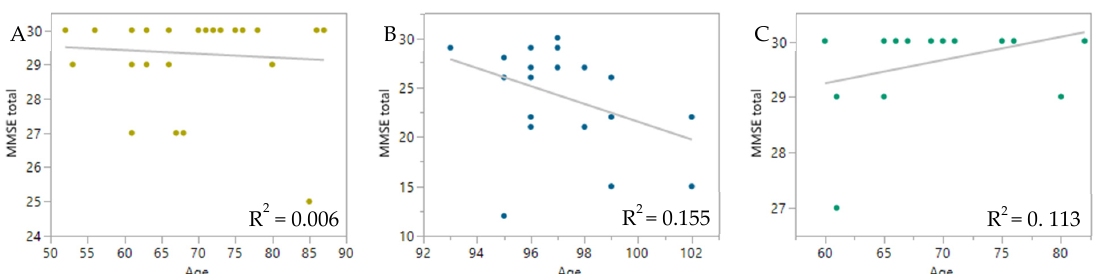
Figure 3. Chronological age vs. DNAm epigenetic age clocks. N control = 28, N ELLI = 24, and N o ff spring = 18. ( A ) DNAmPhenoAge as a function of chronological age, R 2 = 0.716, p < 0.001. ( B ) DNAmGrimAge as a function of chronological age, R 2 = 0.919, p < 0.001. Linear regressions performed and plotted using JMP 14 (SAS Institute Inc., Cary, NC, USA).